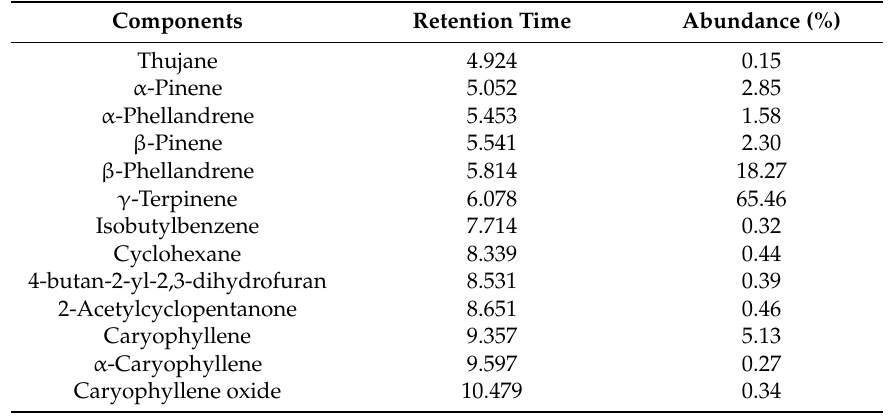
Table 1. Composition of essential oil of Bursera morelensis identified by GC–MS (Gas Chromatography– Mass Spectrometry) analysis.